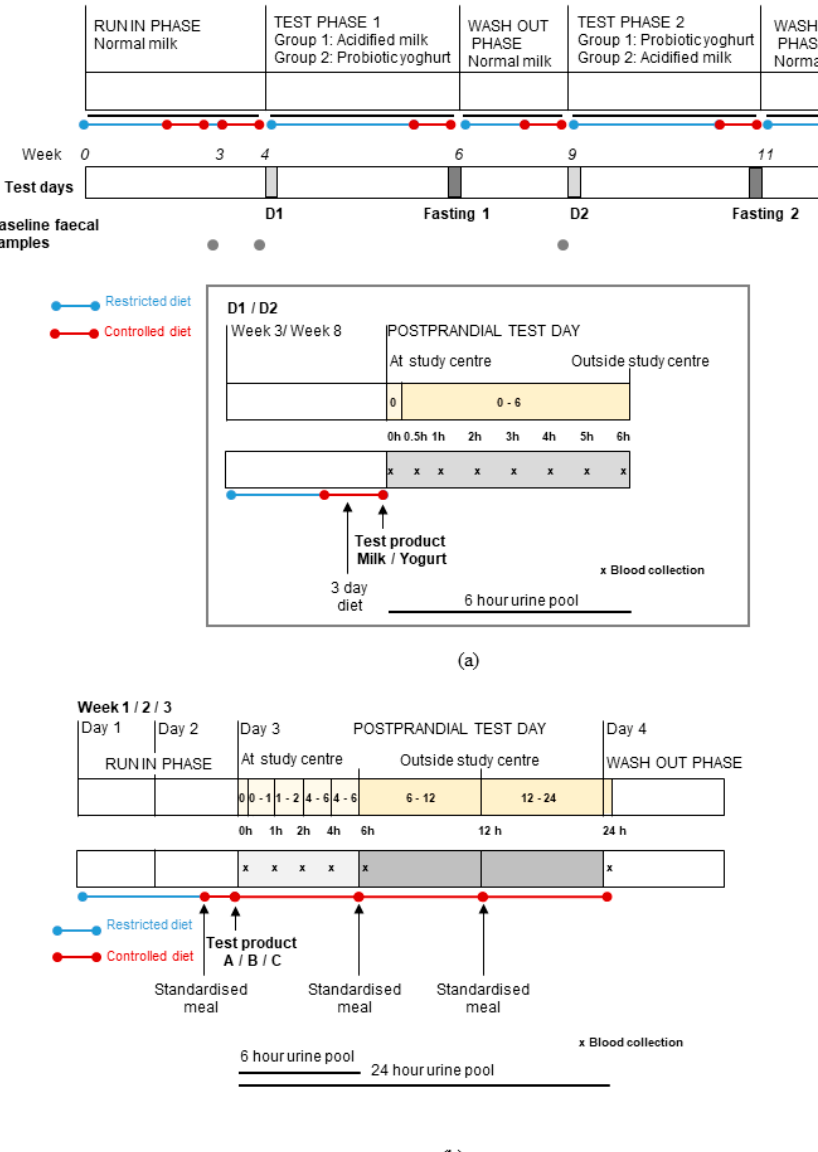
Figure 1. Overview of the study designs used for two randomised, controlled, cross-over trials that compared the postprandial and short-term effects of consuming fermented or non-fermented dairy products (adapted from Burton et al. and Münger et al.) [24,25]. ( a ) In Study 1, volunteers ( n = 14) were assigned to test probiotic yogurt and acidified milk in random order during two test phases. At the beginning of each test phase, postprandial dairy tests (D1 and D2) were conducted while the effects of two-week daily consumption of each product were assessed by fasting tests (Fasting 1 and 2). ( b ) In Study 2, test products were administered to volunteers ( n = 11) in random order (A = milk, B = cheese, C = Soy drink) and their effects were evaluated by postprandial tests. For both studies, on postprandial test days, blood ( x ) and urine sampling (intervals shown by yellow blocks) was completed as indicated on the schematics. Fasting blood and urine samples were collected on each test day. In Study 1, pre-test faecal samples were collected during the run-in and wash-out phases. Dietary restrictions were applied during the studies with the provision of a three-day controlled diet (Study 1) and a standardised meal (Study 2) before each test day.